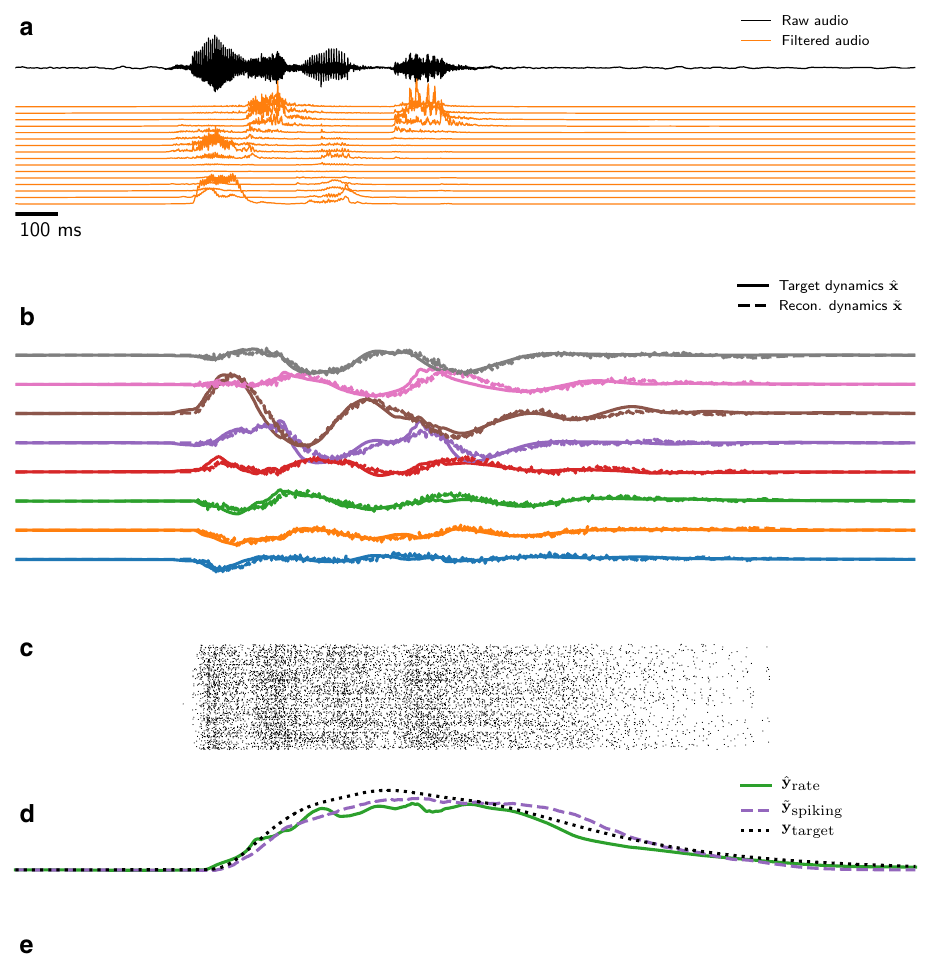
Figure 3. Our approach performs a supervised spoken audio multi-dimensional classification task with high accuracy. ( a ) Audio samples were presented that either matched a spoken target phrase, or consisted of random speech or background noise. Raw audio (black) was filtered into 16 channels (orange) for classification by the 16 network ( c ∈ R ). ( b ) Internal RNN dynamics ( ˆ x ; solid) was reconstructed accurately by the trained spiking ADS network ( ˜ x ; dashed) based on the spiking activity (shown in c ). An output signal was high (shown in d ) when the audio sample matched the target signal, or low (shown in e ) when the audio signal was background noise or other speech. Panels ( a )–( d ) correspond to a single